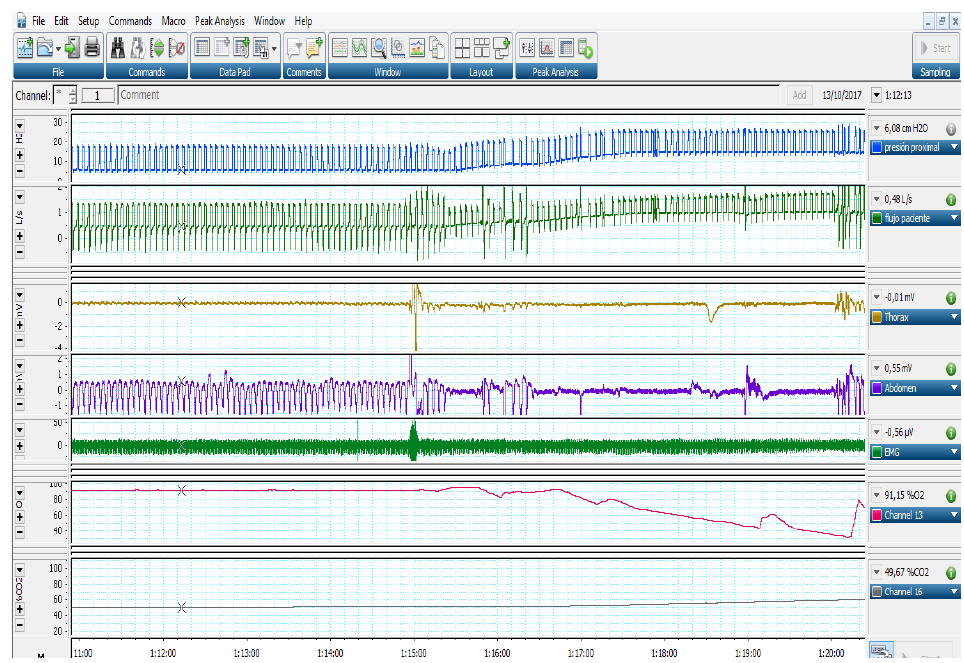
Figure 5. Example of inappropriate response of an automatic mode in a patient with UAO without effort (glottic closure). Observe the absence of movement in belts (Channels 3 and 4). In this case, the increase in pressure (Channel 1) was associated with a profound desaturation (Channel 6) and transcutaneous CO 2 increase (Channel 7).